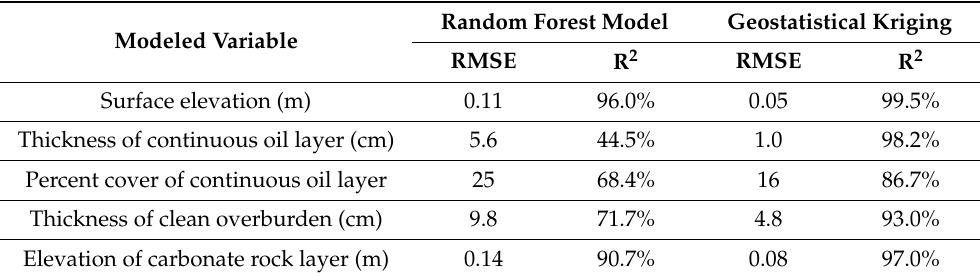
Table 1. Cross-validated root mean squared error (RMSE) and pseudo-R2, or % of variance ex- plained, for initial random forest model and after subsequent geostatistical kriging interpolation. Estimates derived from spatially blocked, 10-fold cross-validation for random forests and 5-fold for geostatistical kriging.